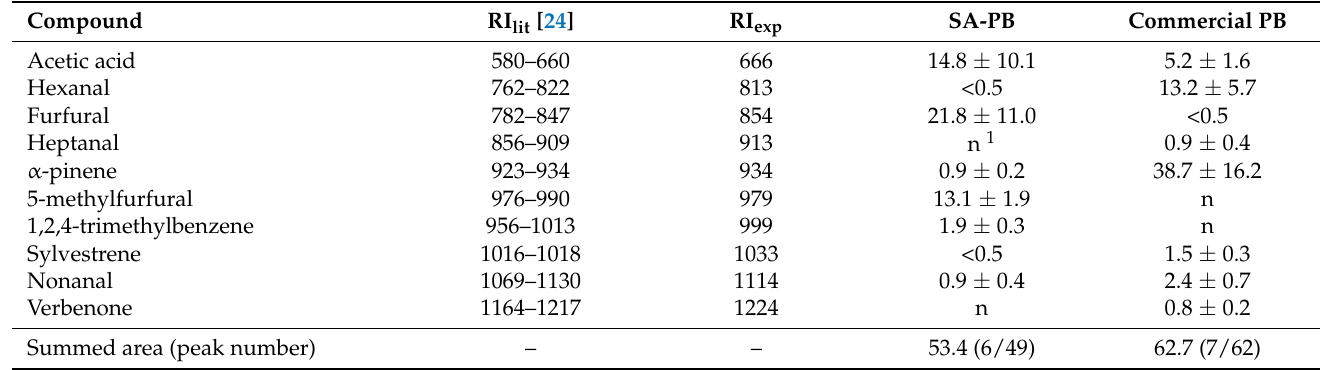
Table 5. The most abundant identified VOCs and their relative area % from the total peaks in SPME-GC-MS chromatograms of the adhesive-bonded